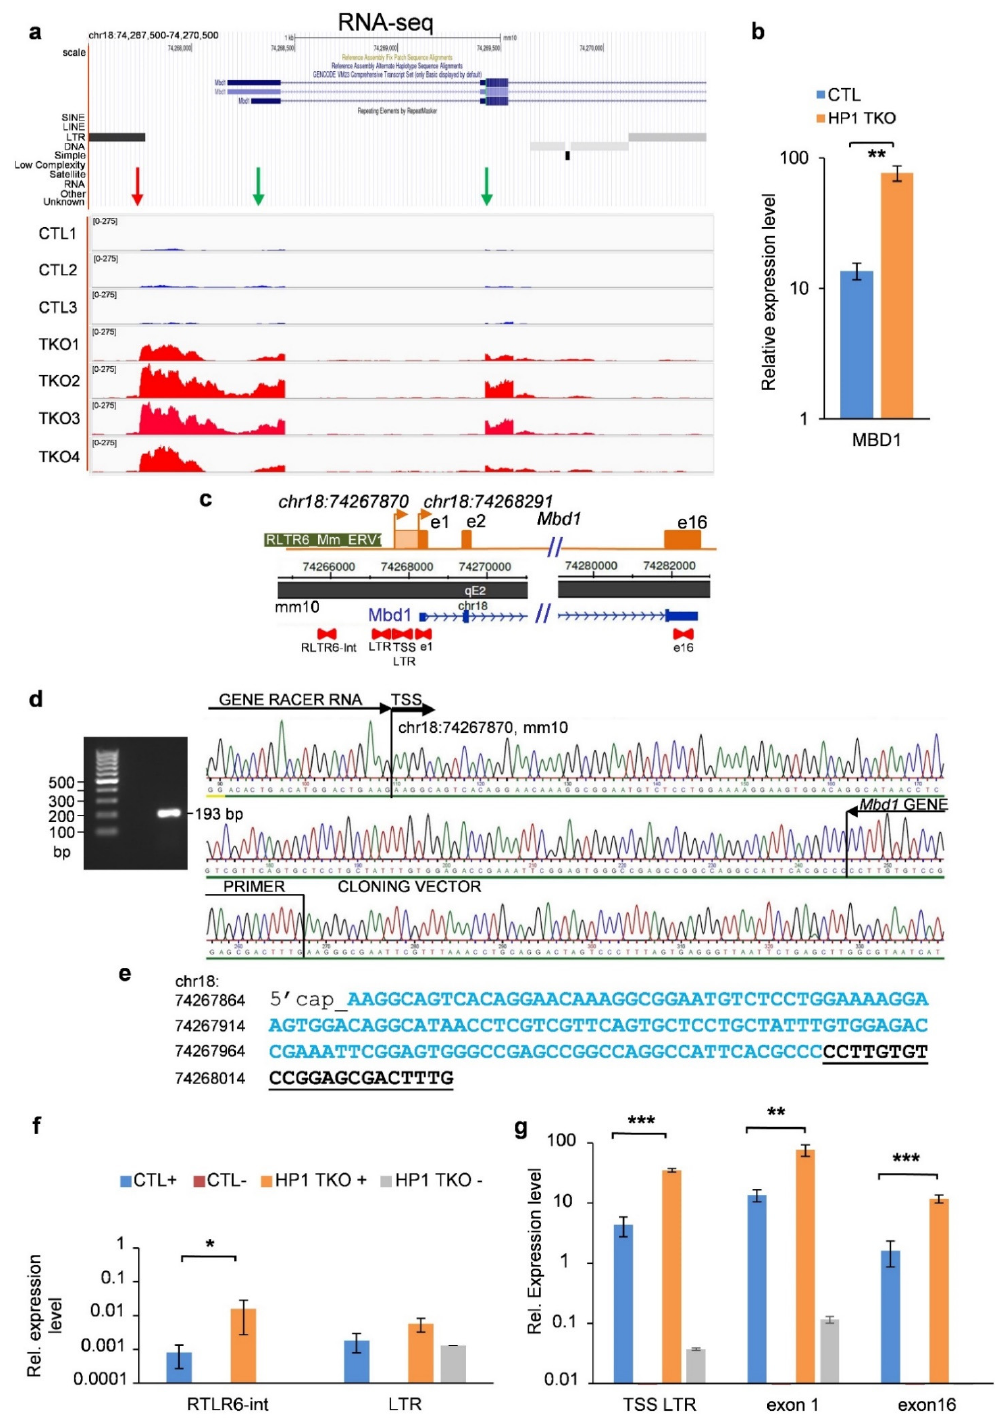
Figure 1. Endogenous and ERV-derived upstream promoters of Mbd1 are controlled by HP1 proteins. ( a ) Genome Browser snapshot of RNA-seq data at the Mbd1 locus. Mbd1 mRNA levels were found to be highly increased in HP1-TKO compared to control livers (green arrows), as well as in one intergenic LTR sequence located 517 bp upstream of the Transcriptional Start Site of the endogenous Mbd1 gene promoter (red arrow on the left). ( b ) RT-qPCRs were performed on total RNA from